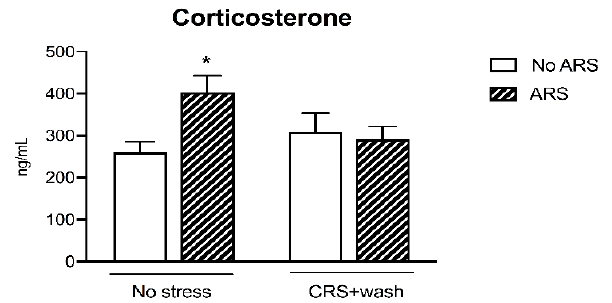
Figure 1. Analysis of corticosterone plasma levels in chronic restraint stress (CRS) rats exposed to an acute challenge (acute restraint stress (ARS)) after 3 weeks of washout (wash). The data are the mean ± SEM. * p < 0.05 vs. No stress/No ARS (two-way ANOVA with PLSD).